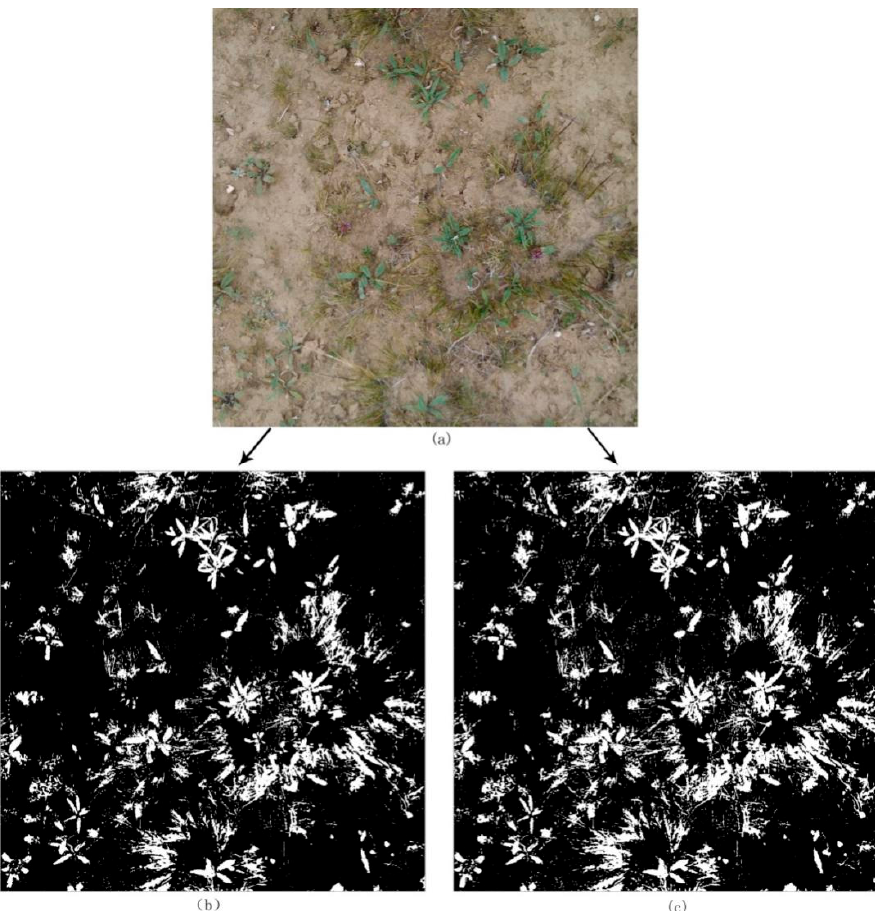
Figure 5. Comparison of results of vegetation areas extracted by a di ff erent person (( a ) is the original image, and ( b , c ) are the fractional vegetation cover (FVC) information extraction results of this di ff erent person, respectively, while white and black represent vegetation and non-vegetation, respectively).